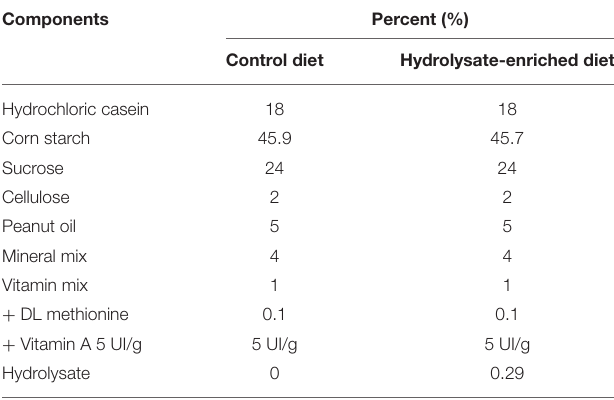
TABLE 1 | Composition of the control and the hydrolysate-enriched diets.